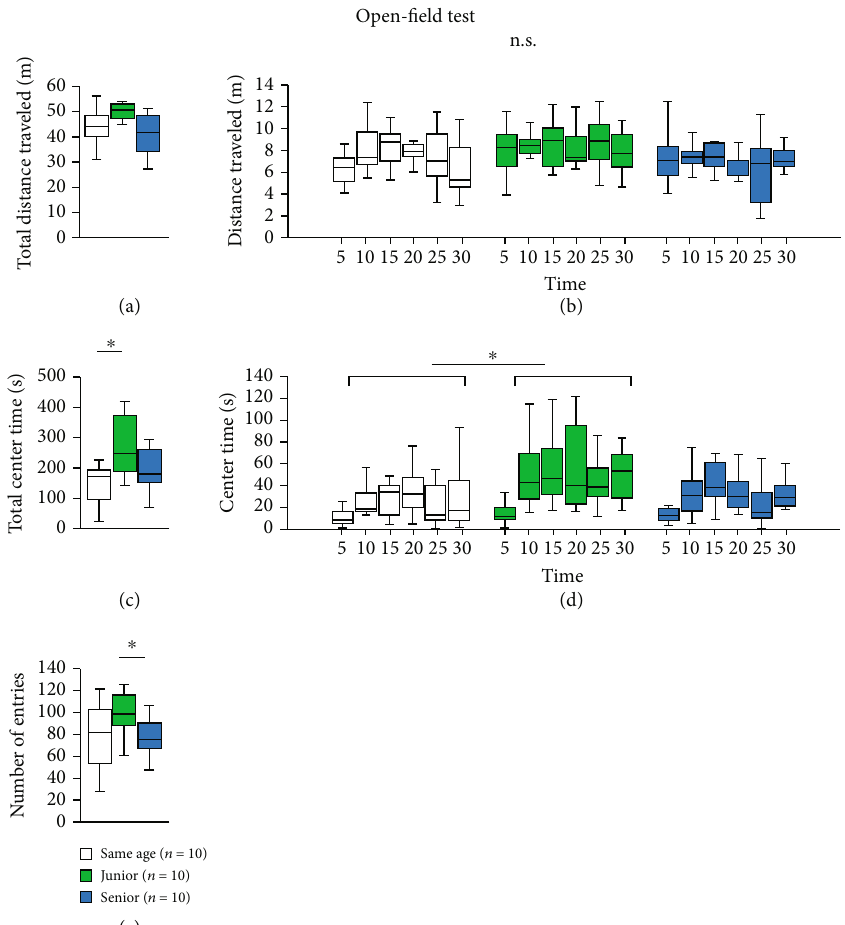
Figure 3: E ff ect of group housing condition on performance in the open- fi eld test. Graphs showing the total distance traveled (a), the distance traveled in each 5 min period (b), the total time spent in the central area (c), the time spent in the central area in each 5min period (d), and the number of entries into the central area (e). All data are presented as box plots. ∗ Signi fi cant di ff erence in comparisons between groups ( p < 0 : 05 ). The p values were calculated using two-way ANOVA in (a), (c), and (e), and two-way repeated measures ANOVA in (b) and